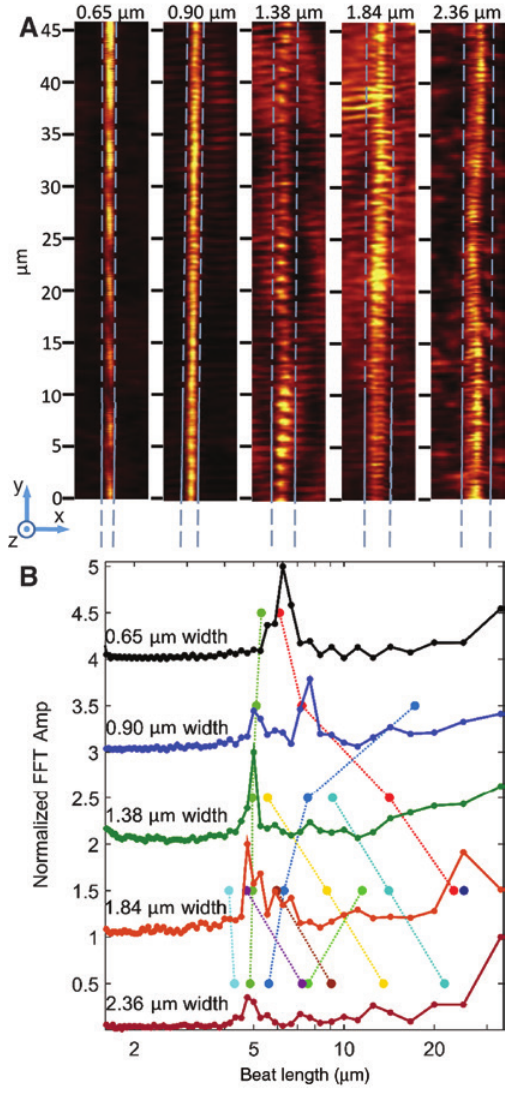
surface of waveguides with widths ranging from 0.65 to 2.36 μ m (measured by scanning electron microscopy). In Figure 4, NSOM images obtained with horizontally polar- ized waveguide excitation are shown alongside corre- sponding Comsol simulations of electric field-magnitude squared for 0.90- and 2.36- μ m waveguide widths. Features with a number of different periodicities are evident in the signal along the longitudinal direction, with the smallest Figure 5: (A) NSOM images of a 46- μ m region of each fabricated waveguide. Blue lines outline the physical edges of the waveguide, feature ~ 0.2 μ m in size (indicated by an arrow on 2.36- μ m concurrently measured by the NSOM tip. (3 μ m scale bar) (B). Waterfall waveguide in Figure 4C). These smallest features are due plot of FFTs of near-field intensity taken along each waveguide in (A). to Fabry-Perot interference fringes formed by the wave- Periodic features present, but obscured in (A), show up as peaks in guide end facets. Such fringes would have a spacing of the FFTs. The excitation source is polarized at 45 ° with respect to the approximately λ /(2n ) ≈ 0.23 μ m, a sub-diffraction limited substrate plane for all waveguides. Colored dots and connecting lines eff feature resolvable due to our ~ 90-nm NSOM tip aperture. indicate the computationally determined beat lengths for the respec- tive waveguide widths (colors correspond to curves in Figure 3).